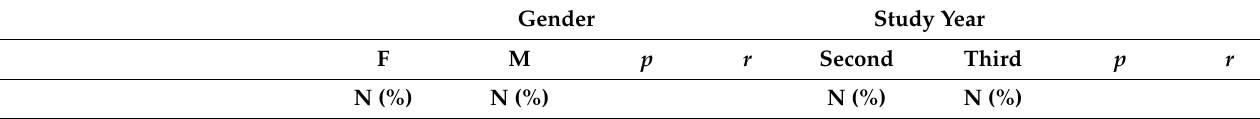
Table 5. Assessing the perception of the knowledge level regarding the post-exposure attitude in the case of a patient contaminated with HBV, HCV, or HIV and the knowledge on the technique of one-hand needle cover. Comparative data and Chi-square